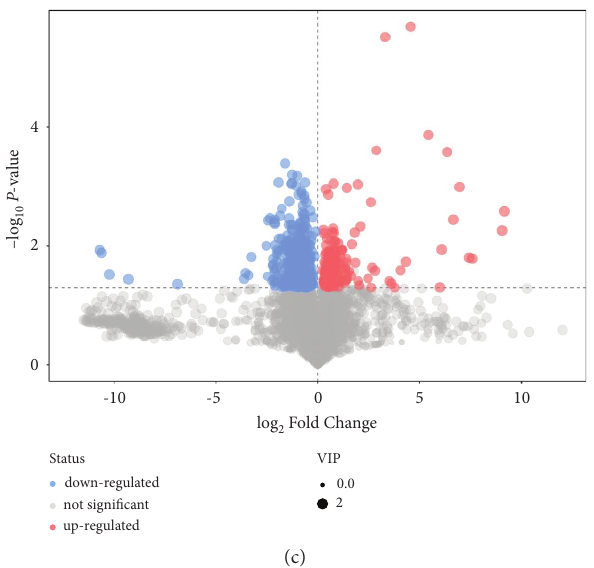
Figure 4: Screening volcano plot of differential lipids between two groups of rats with different feedary interventions (negative ion mode). (Remarks: (a) high-fat feed group vs. high-dose reconstituted rice group; (b) high-fat feed group vs. ordinary rice group; and (c) high-dose reconstituted rice group vs. ordinary rice (Table S4), the results of detection in the negative ion mode 5 FA, 10 PC, 3 LPC, 3 FAHFA (Fatty acid esters of hydroxy fatty acids), 2 OxPI, 4 PE, 3 PI, 1 SQDG (Sulfoquinovo- syldiacylglycerol), 4 Cer/NS, 1 GlcADG (Glucur-